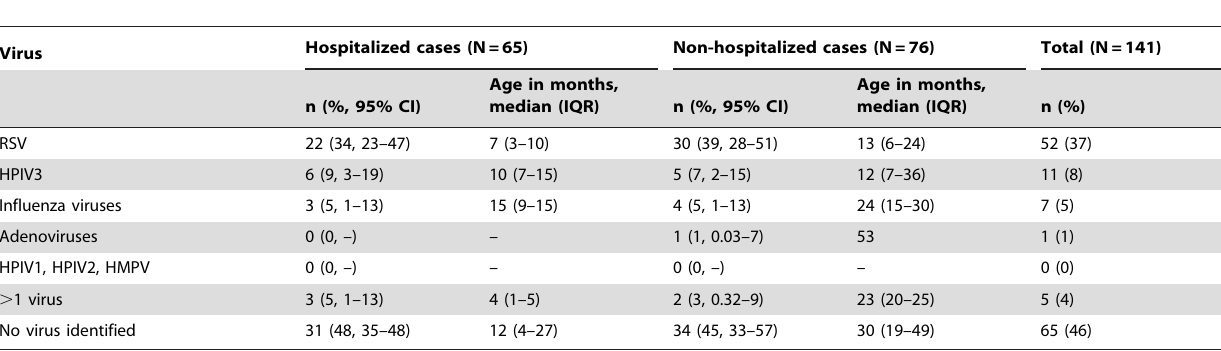
Table 3. Respiratory viruses detected from hospitalized and non-hospitalized children aged , 5 years with severe acute respiratory infections in Matlab, Bangladesh, June–October 2010.